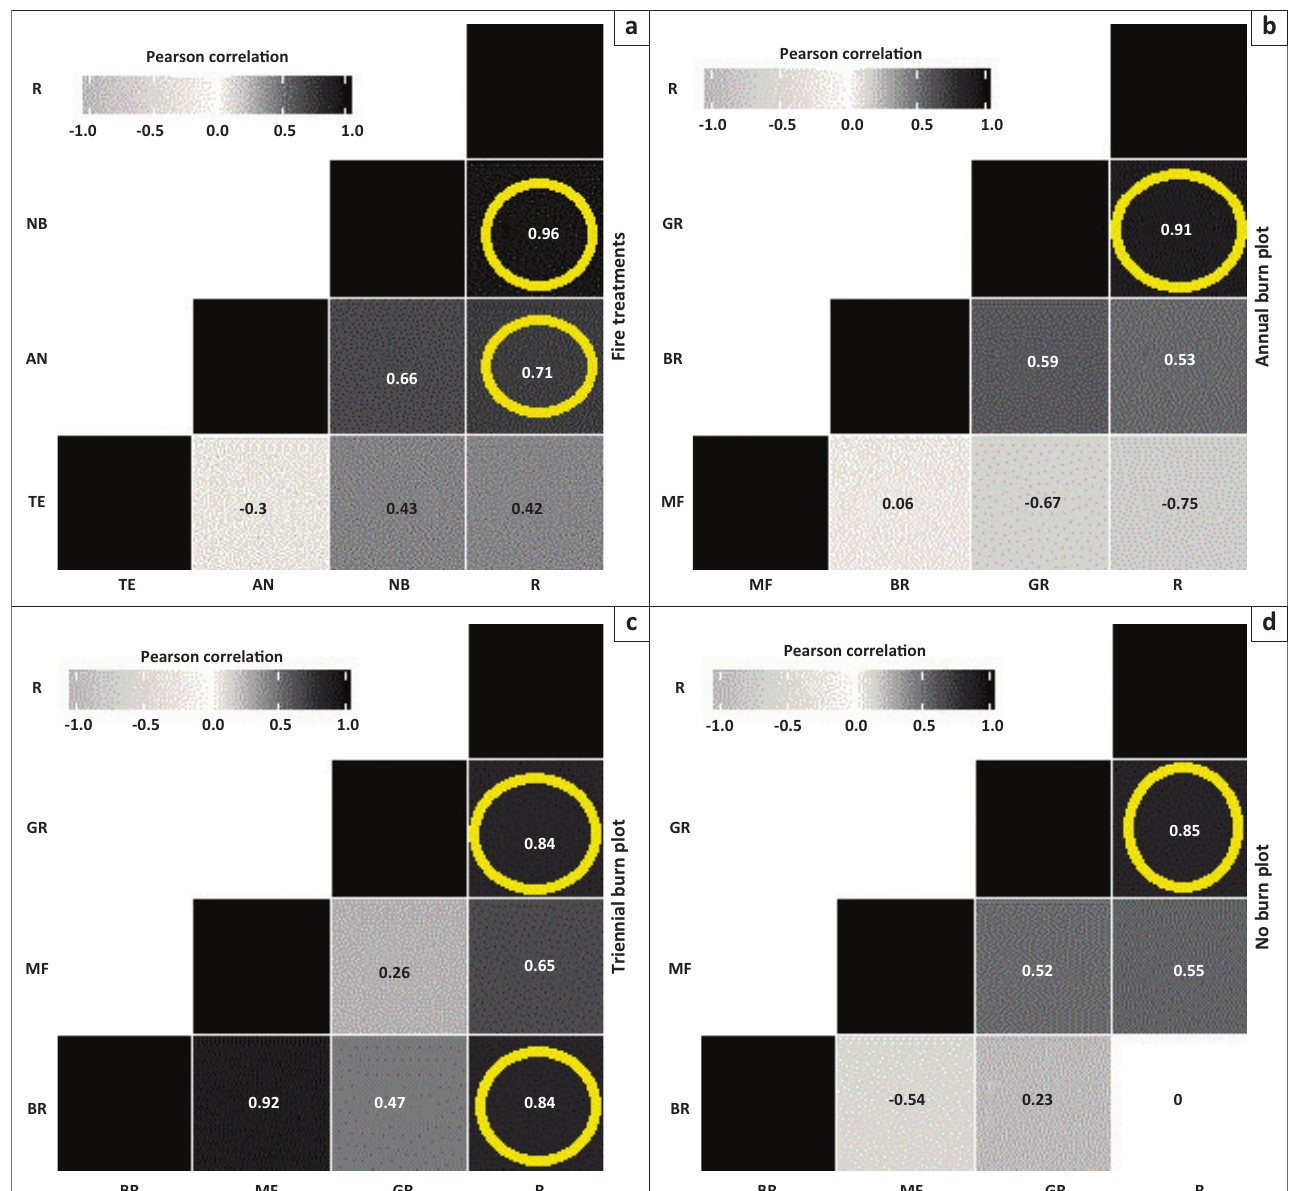
FIGURE 4: Pearson’s correlation showing the relationship between rainfall (R) and overall herbivore density estimate (MF, mixed feeders; BR, browsers and GR, grazers), across all fire treatments (a), and per individual fire treatment, (b) annual (AN), (c) triennial (TE) and (d) no burn (NB), plots of Satara KNP.